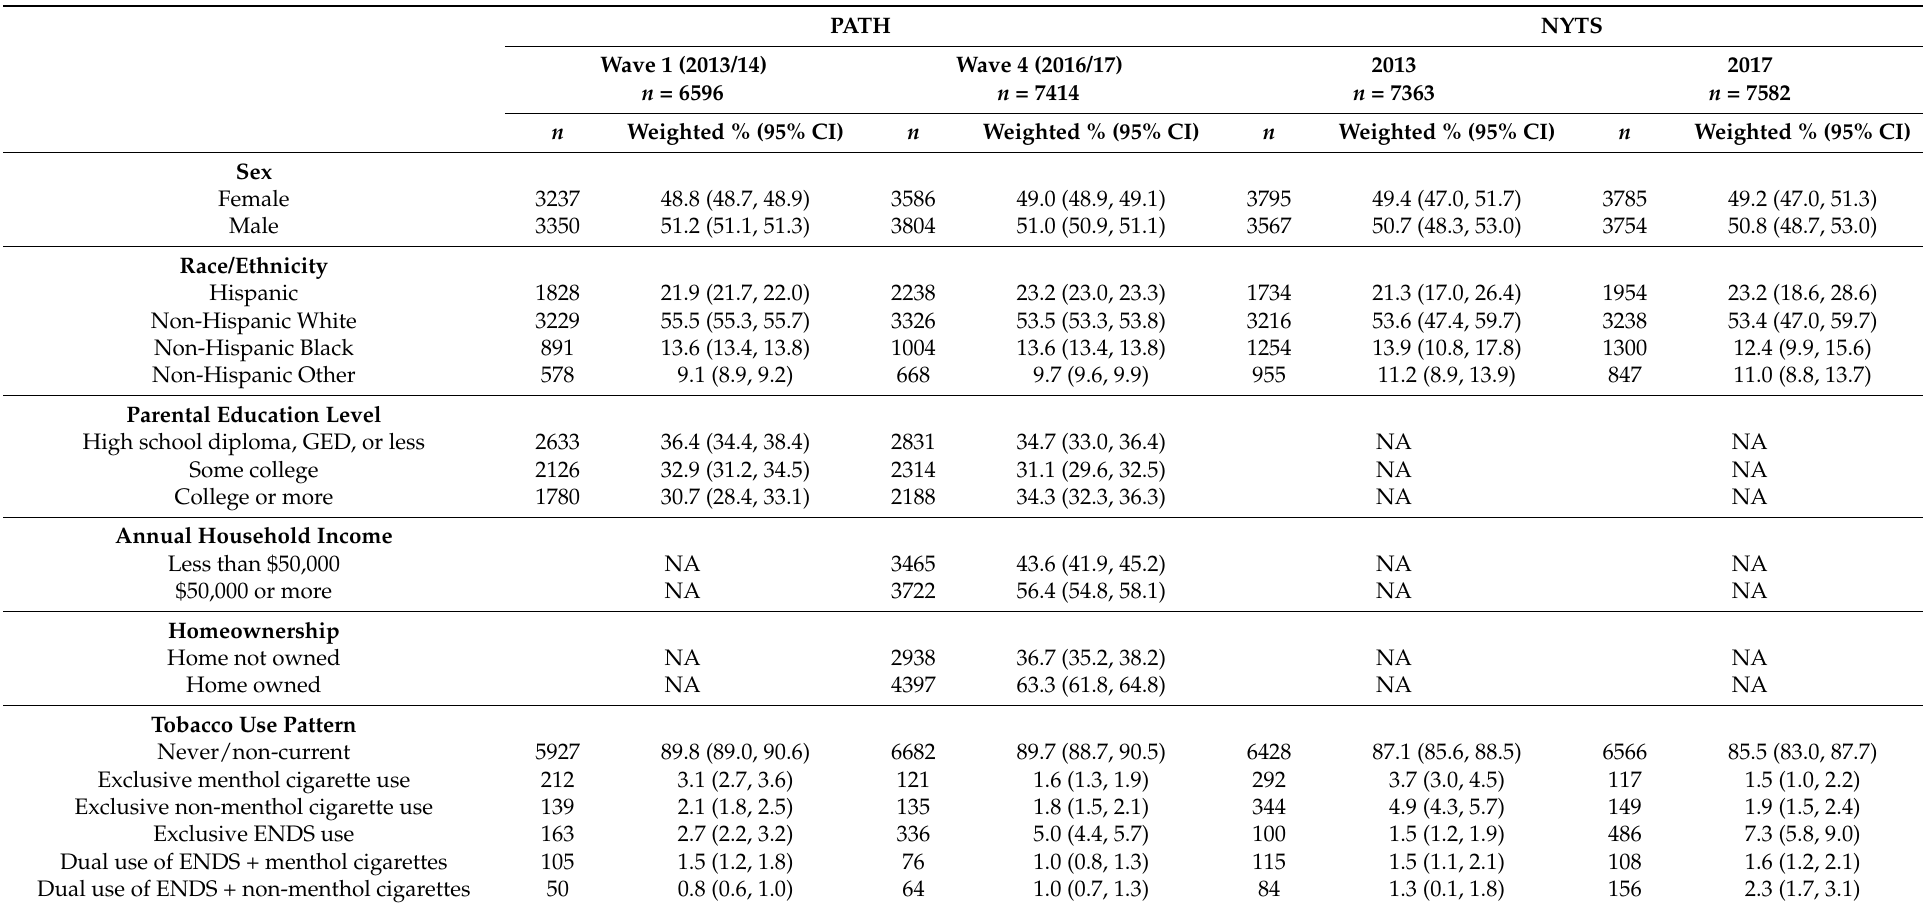
Table 1. Sociodemographic characteristics and overall ENDS and cigarette use patterns of 15–17-year-olds in 2013 and 2017. Population Assessment of Tobacco and Health (PATH) and National Youth Tobacco Survey